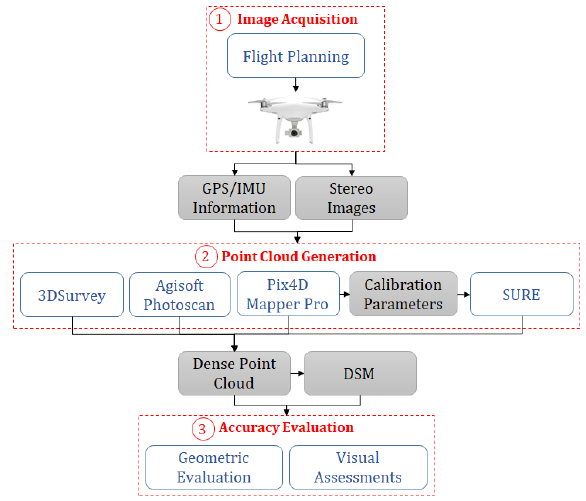
Figure 1. Main flowchart of software comparison